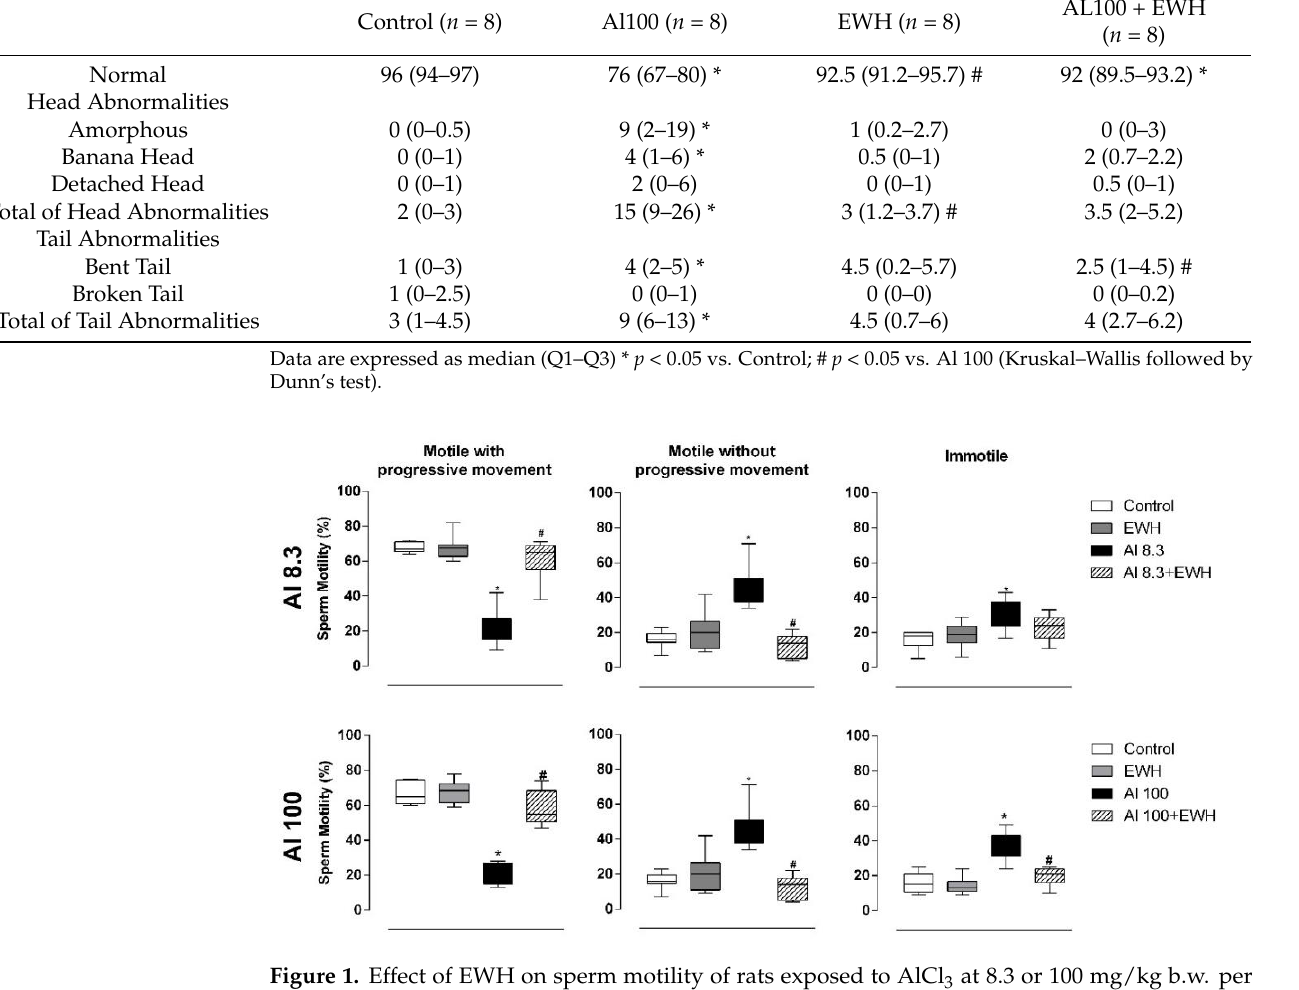
Table 5. Effect of EWH on sperm morphology of rats exposed to AlCl 3 at 8.3 mg/kg for 60 days.